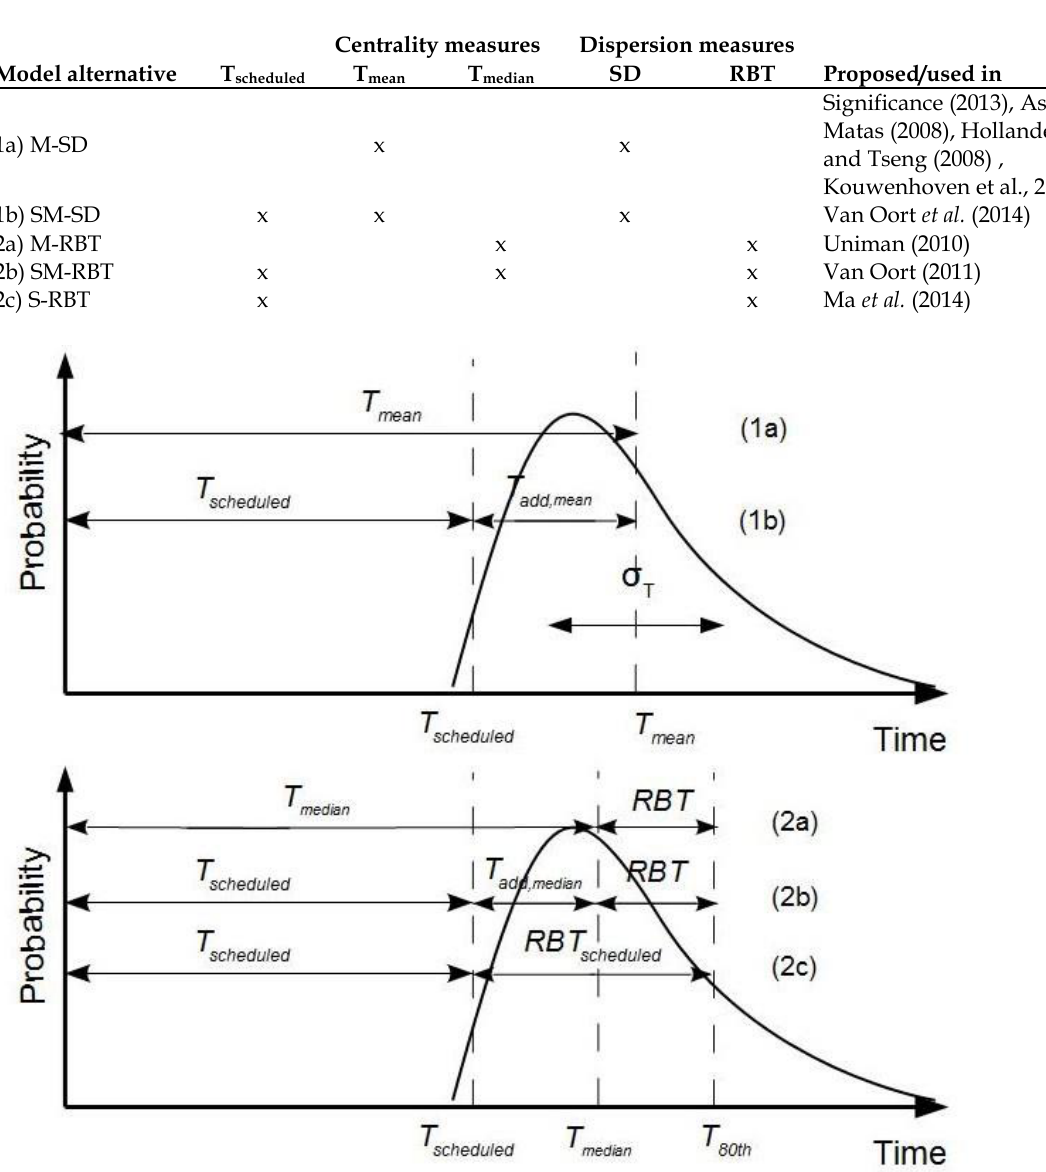
Table 3. Considered model alternatives